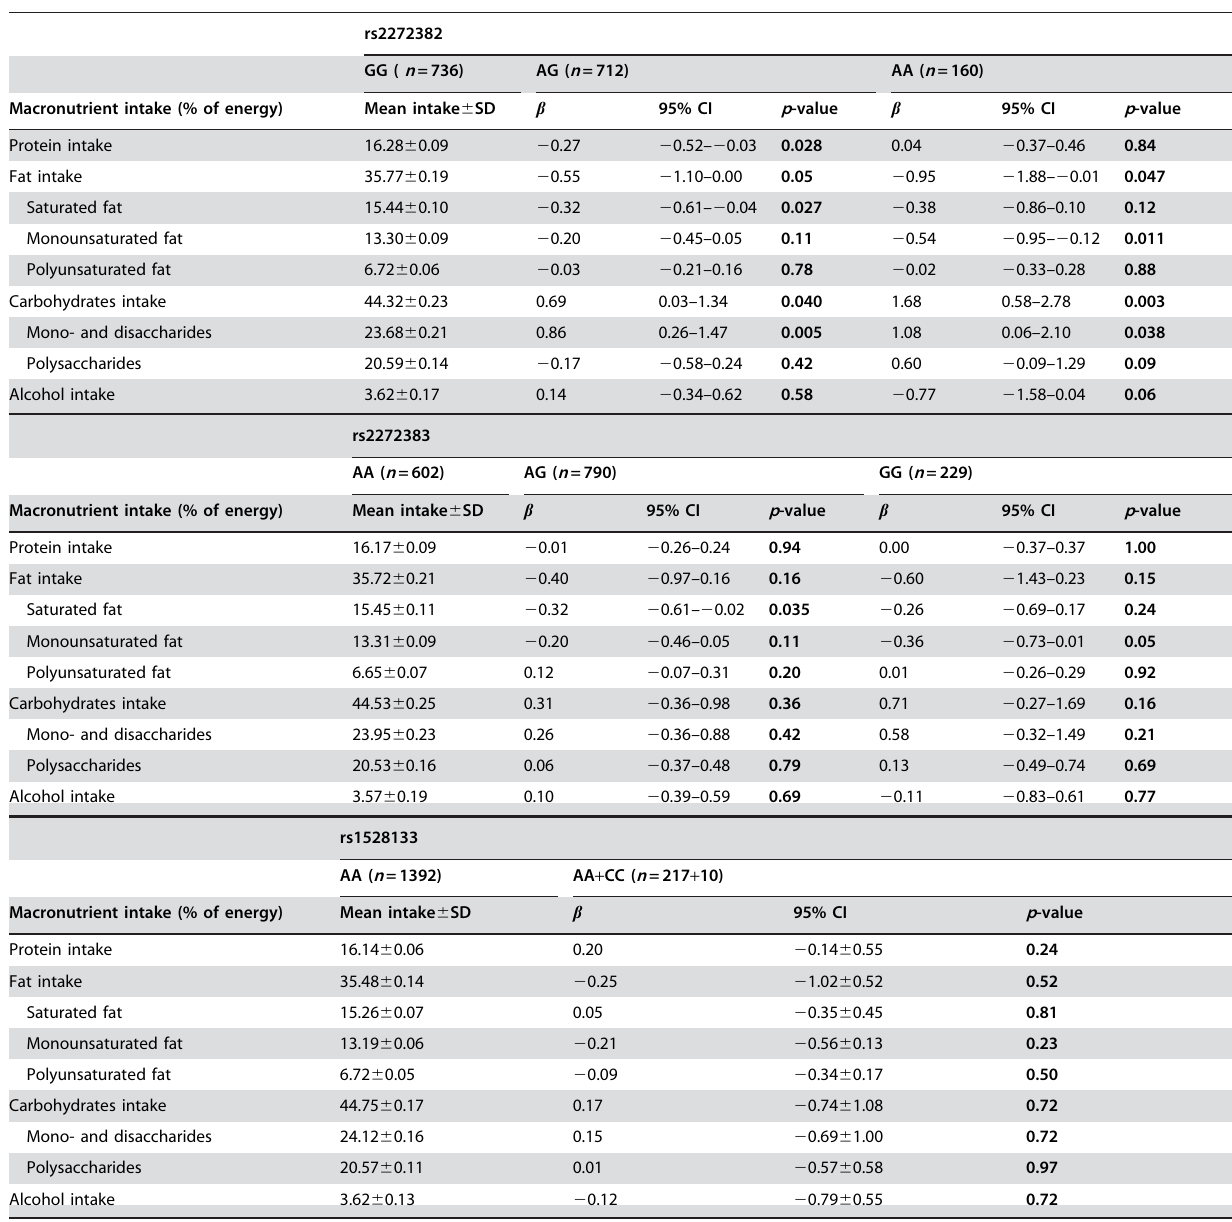
Table 3. Association of dietary phenotypes with the single nucleotide polymorphisms in the TUB gene. .. ... .... ... ... .... ... ... .... ... ... .... ... ... .... ... ... .... ... ... .... ... ... .... ... ... .... ... ... .... ... ... .... ... ... .... ... ... .... ... ... .... ... ...